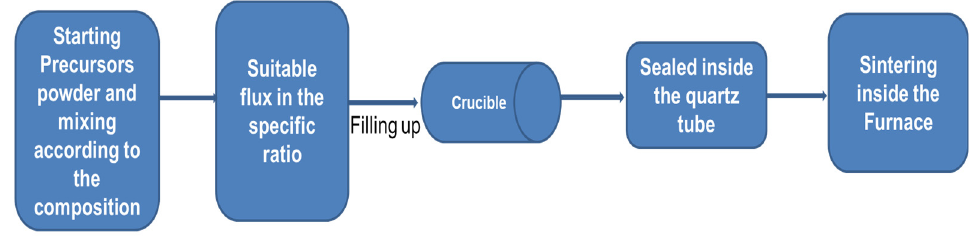
Figure 4. A general block diagram of the flux method. Table 2. List of single crystals reported for the 1111 ( RE FeAsO) and 1144 ( AEA Fe 4 As 4 ) families, including growth conditions and superconducting properties. T syn is used for the synthesis temperature and heating time. FM-AP and FM-HP represent Flux method at ambient pressure and the Flux method at high pressure, respectively. SSCG-AP and SSCG-HP refer to the Solid-State Crystal Growth method at ambient pressure and high pressure, respectively.